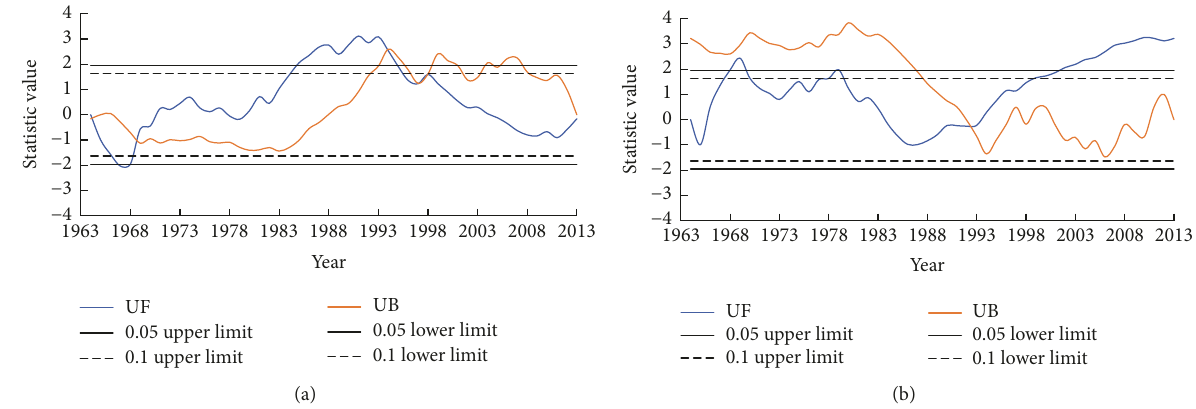
Figure 7: The results of M-K test of (a) SPEI-12 and (b) annual mean